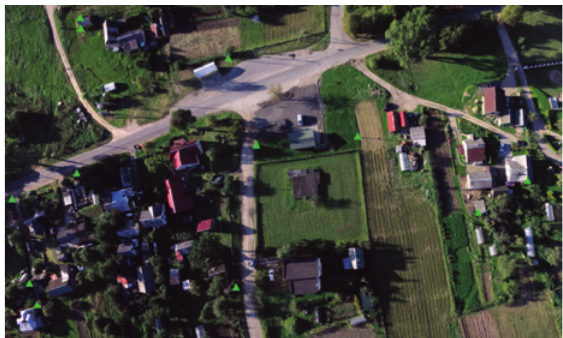
Fig. 6. Fragment of ground control point distribution on the test area